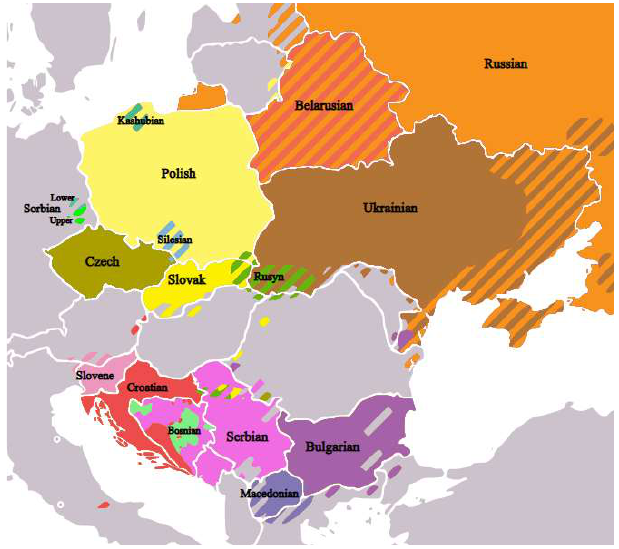
Figure 1. A map showing the geographic distribution of Slavic languages (https://commons.wikimedia.org/wiki/File:Slavic_languages_map_en.svg , accessed on: 2 May 2022).